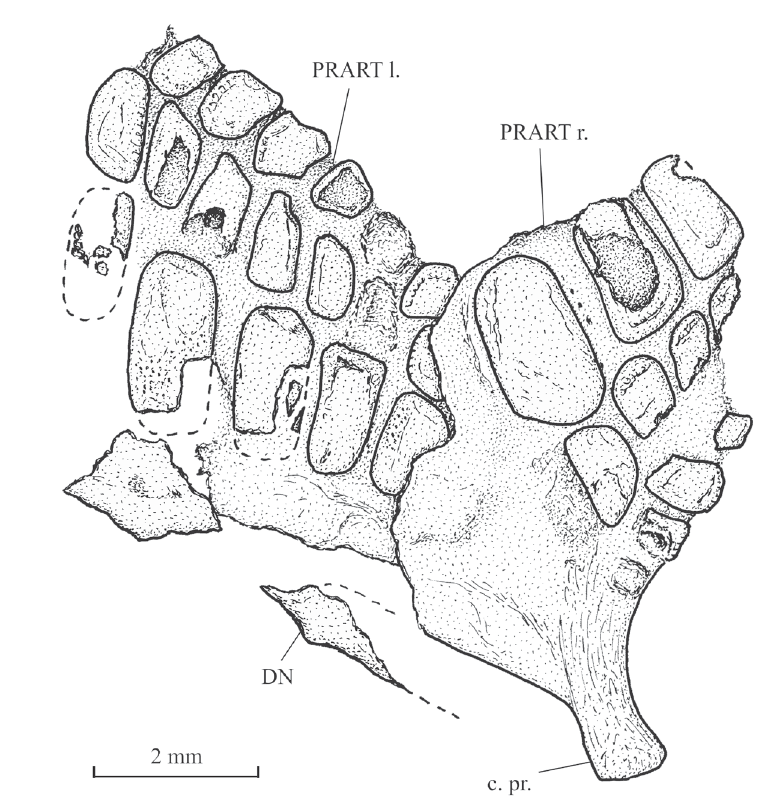
Fig. 6. Libanopycnodus wenzi gen. et sp. nov., holotype, the two prearticulars (CLC